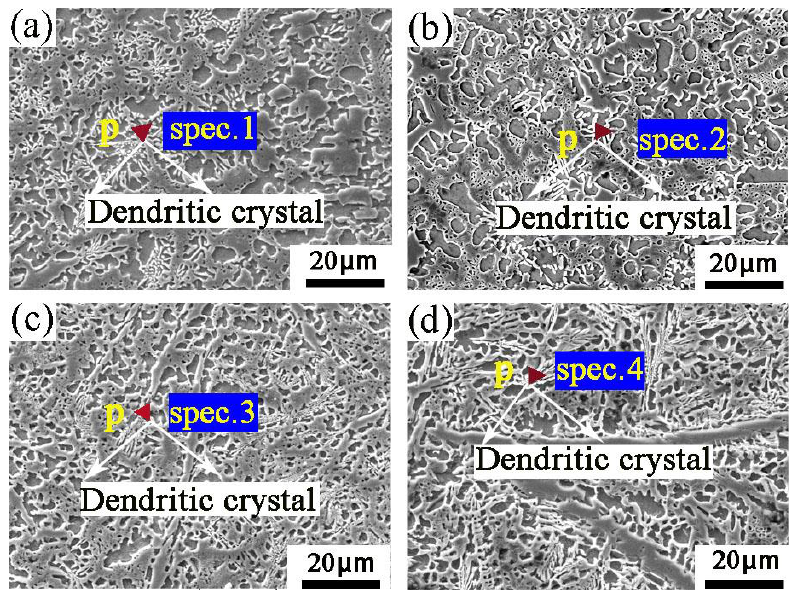
Figure 3. Microstructures of the composite coatings with different heat−treatment temperatures: ( a ) 25 ◦ C; ( b ) 500 ◦ C; ( c ) 600 ◦ C; ( d ) 700 ◦ Table 2. EDS results of the coating.